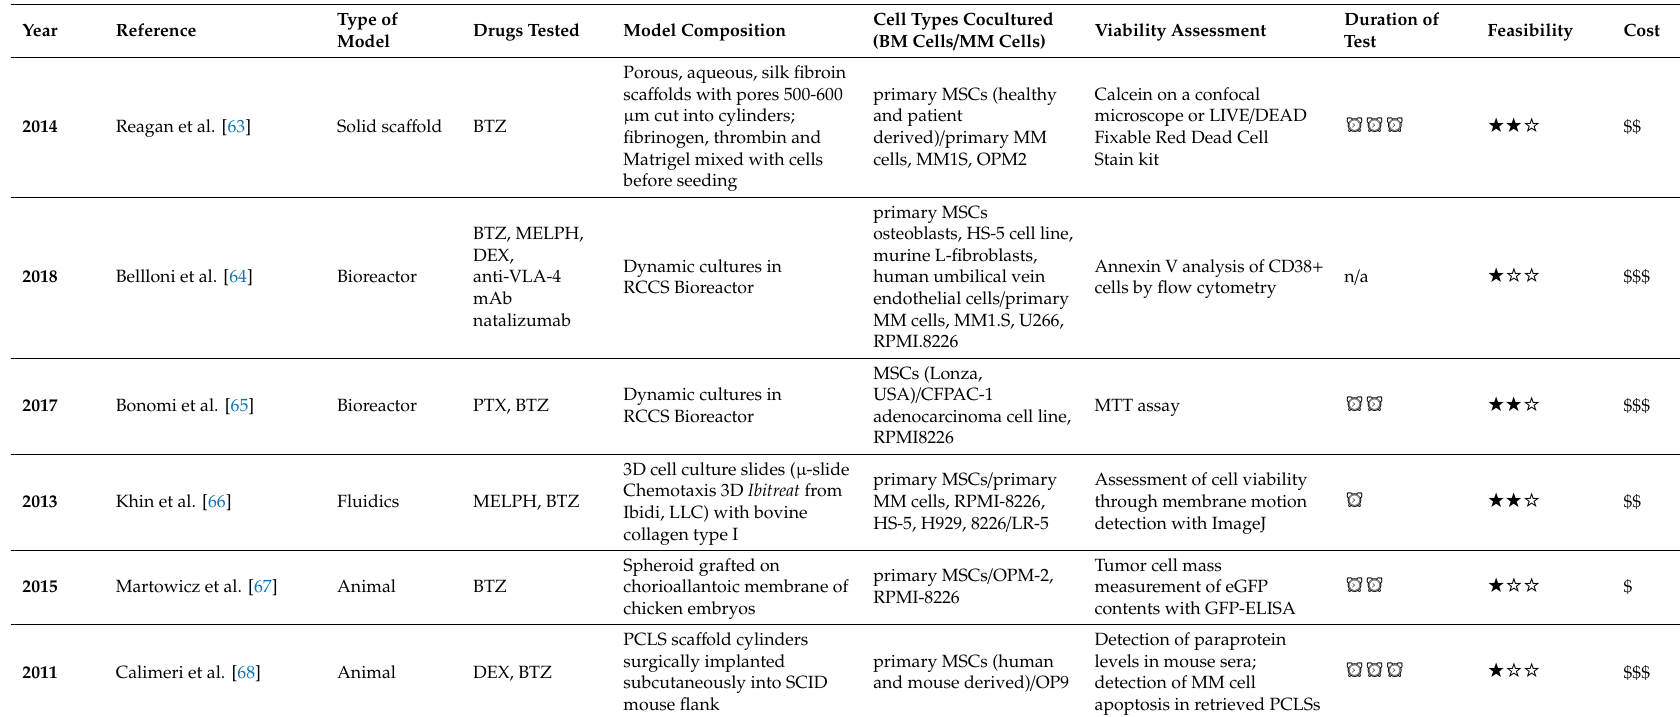
algorithm computing